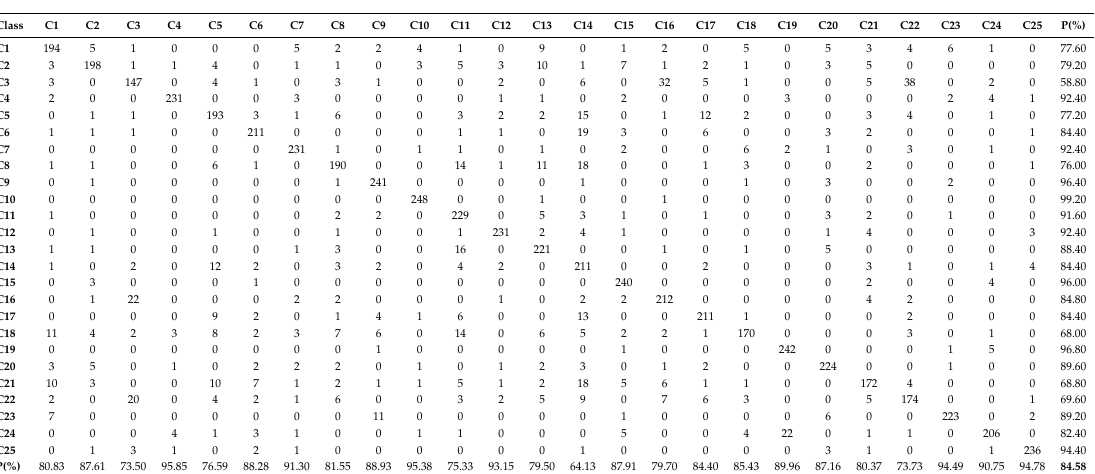
Table 5. Confusion matrix of classification results based on